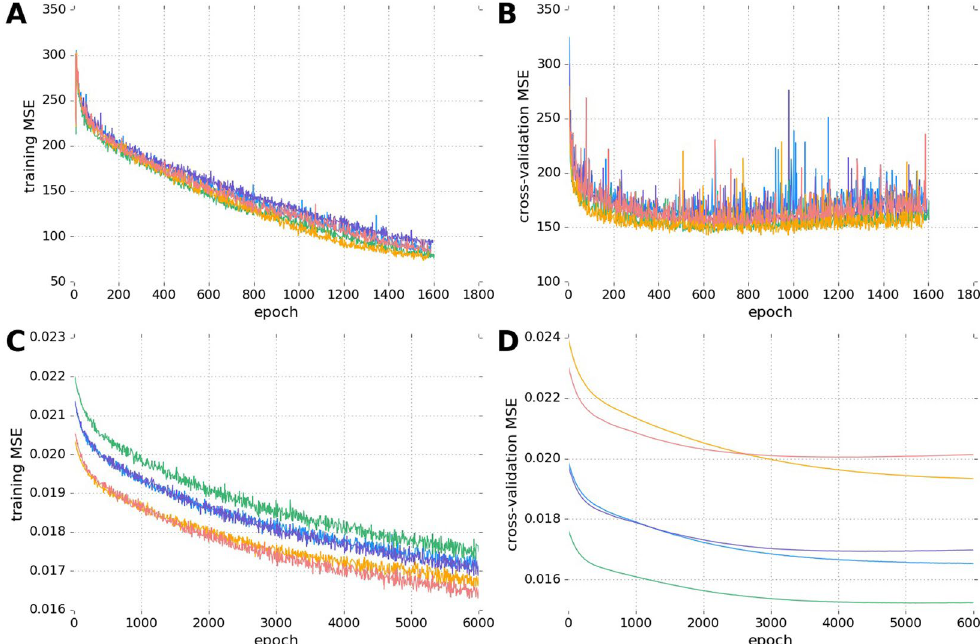
Figure 4. Learning curves for the CNN age and hazard predictor models. Learning curves for age-predicting model CNN_Age are shown for each of 5 folds for the training ( A ) and test ( B ) subsets. Cross-validation learning curves (B) show a minimum of MSE at epochs 500–800, while further training results in model overfitting. Panels (C,D) show the learning curves for the mortality risk-predicting CNN model. Here some of the cross-validation learning curves show a minimum of MSE at epoch 3000. Learning curves are color-coded according to the fold number in the 5-fold training/cross-validation